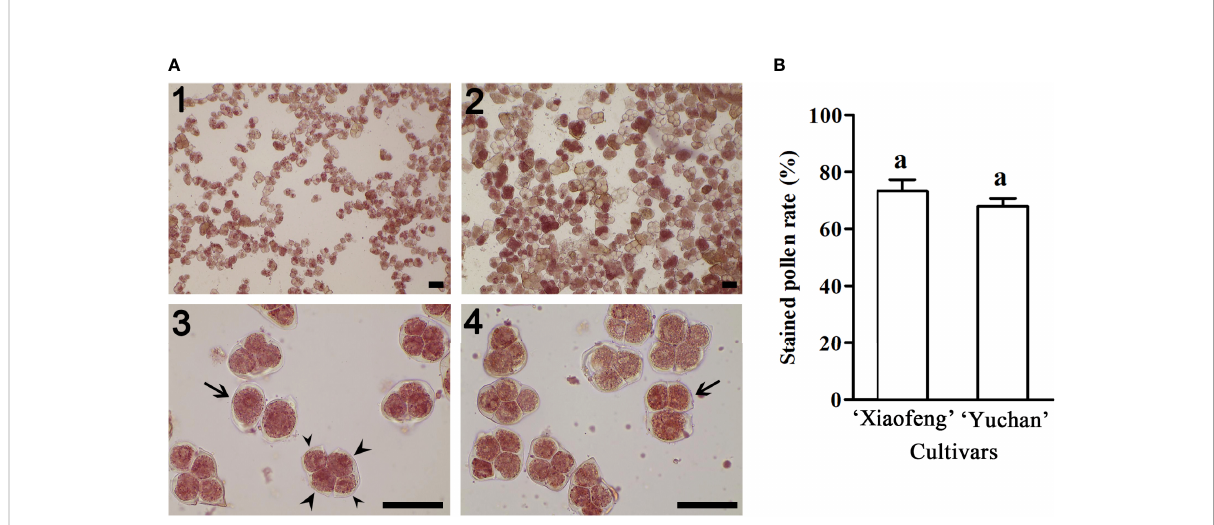
FIGURE 3 Pollen fertility of ‘ Xiaofeng ’ and ‘ Yuchan ’ . (A) Pollen stained with 2, 3, 5-triphenyltetrazolium chloride: Pollen grains of (1) ‘ Xiaofeng ’ and (2) ‘ Yuchan ’ , (3) ‘ Yuchan ’ pollens showed dyad (arrow) and tetrad with two small nuclei (small arrowhead) and two big nuclei (big arrowhead), and (4) ‘ Yuchan ’ pollens with triad (arrow). Bar=50 m m. (B) The percentage of stained pollens of ‘ Xiaofeng ’ and ‘ Yuchan ’ , the same letter above the bars indicates no signi fi cant difference between cultivars analyzed by Duncan ’ s multiple range test at P < 0.05